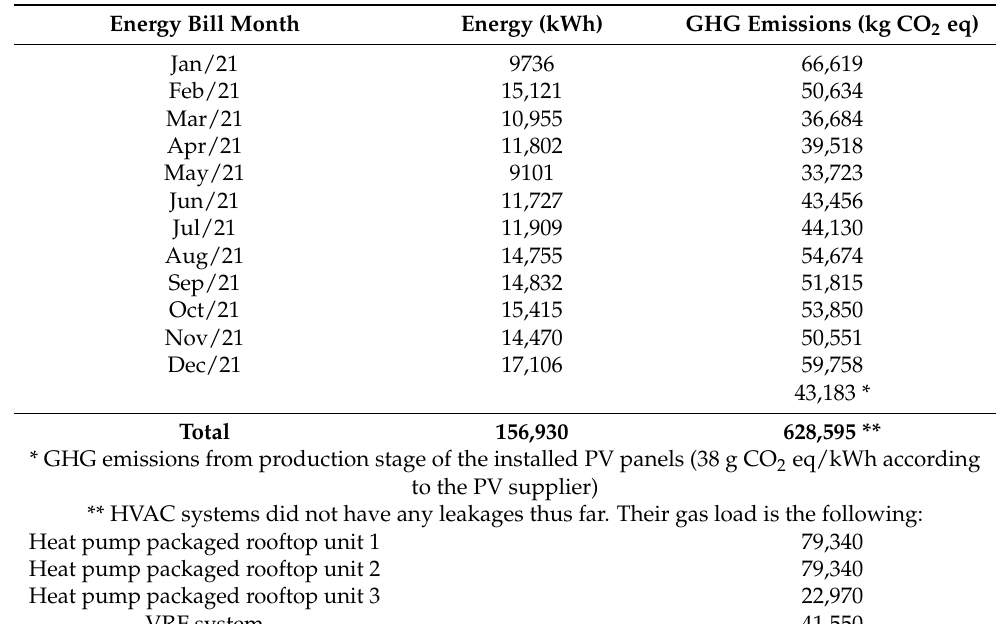
Table 5. Annual energy consumption and related GHG emissions according to the store’s energy bills. Energy Bill Month Energy